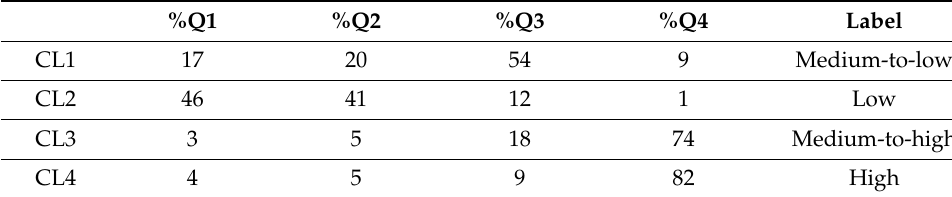
Table 3. Quartile distribution of the IDR_POPP2 variable in the four clusters.